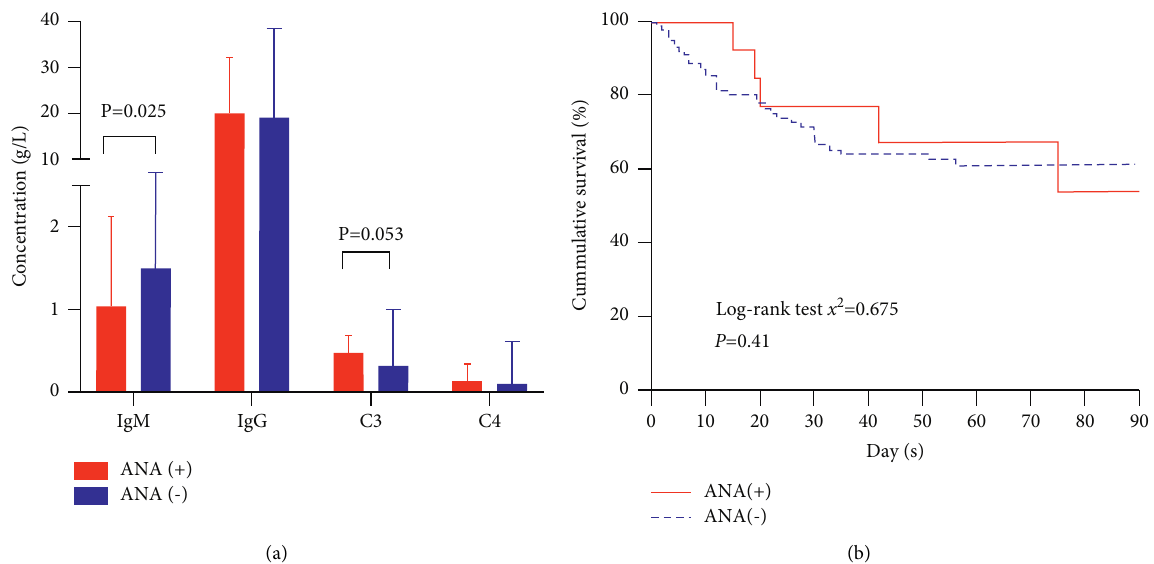
Figure 2: Comparison of immunoglobulin (Ig), complements, and survival between antinuclear antibody positive and negative patients with HBV-ACLF. (a) Comparison of IgG and IgM and complement C3 and C4. (b) Kaplan–Meier survival analysis between ANA (+) and ANA ( − ) groups during 90-day follow-up.